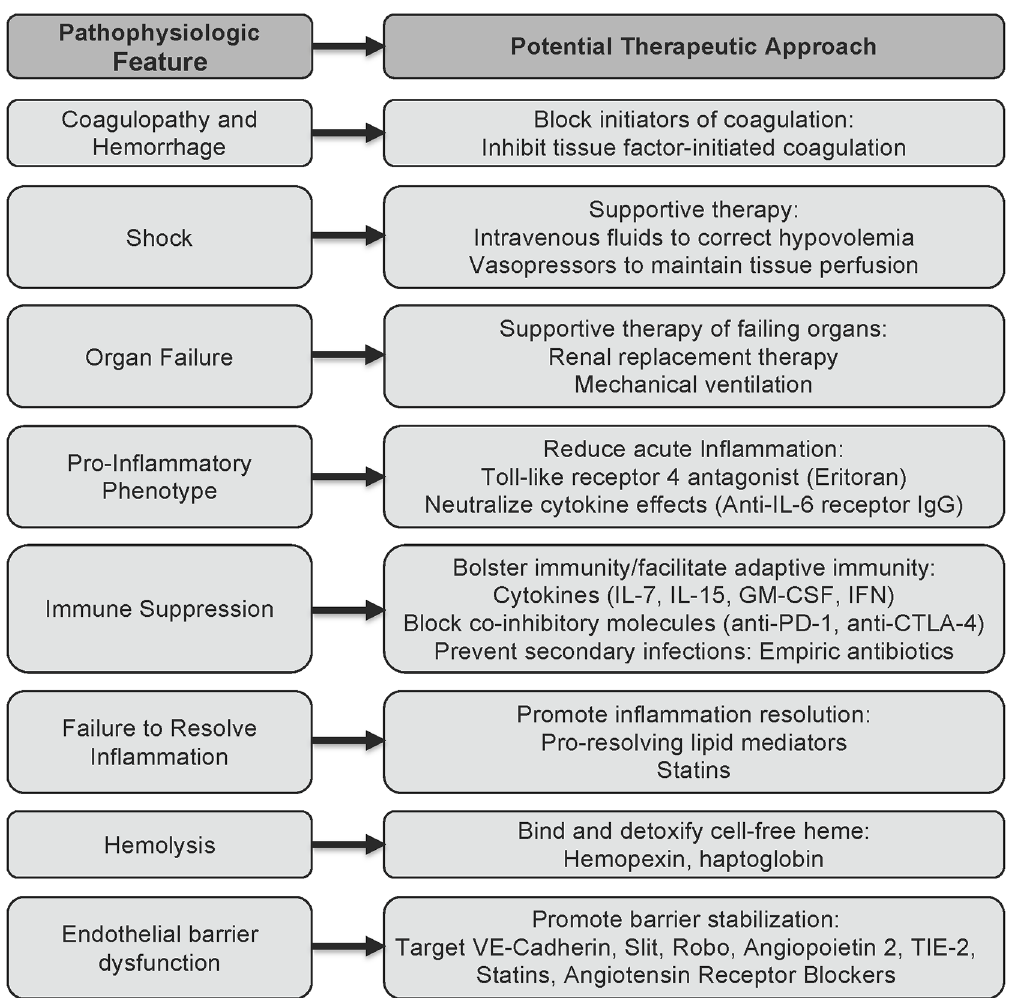
Fig 1. Potential approaches to sepsis caused by viral hemorrhagic fevers based on insights from classical sepsis. The schematic outlines potential approaches to reducing the downstream complications of the viral hemorrhagic fevers, based on what is currently known about the pathophysiology of EBOV sepsis and the state of the art of classical sepsis